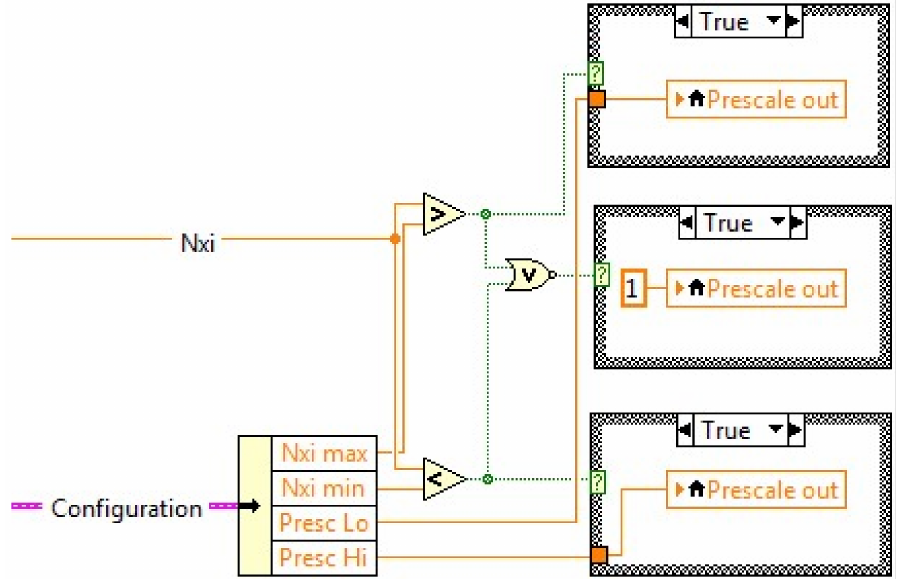
Figure 11. The fragment of the diagram showing the process of comparing the set minimum and maximum states with the current state and depending on the obtained relation of selecting the next frequency division coefficient of the clock generator in the next iteration of the program.